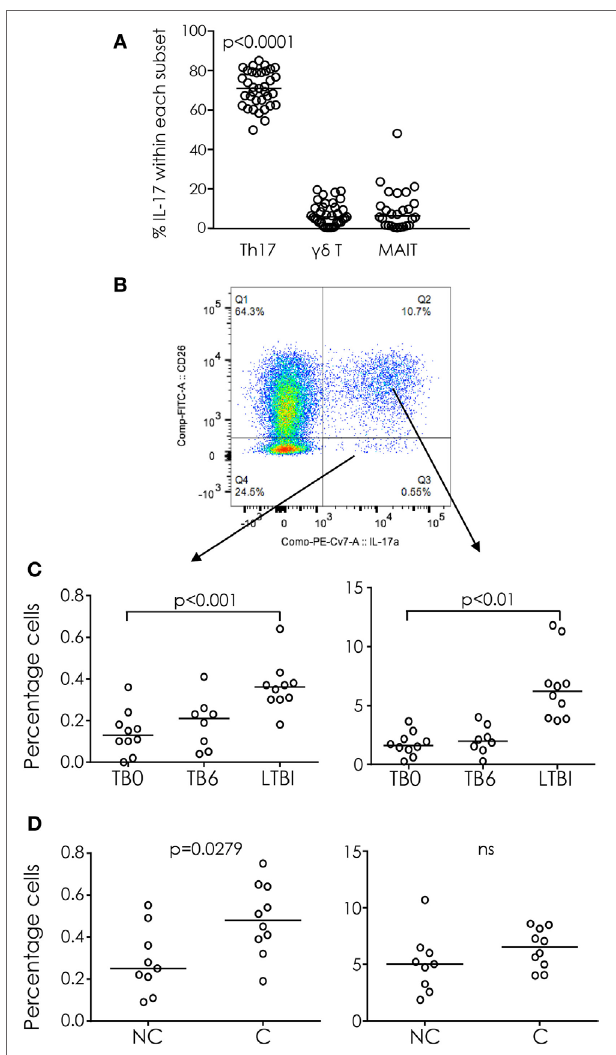
FigUre 1 | IL-17 producing cells in tuberculosis (TB) infection and disease. (a) Percentage of T helper 17 (Th17) cells, γδ T cells, and mucosal-associated invariant T (MAIT) cells within total IL-17 + cells (gated from lymphocytes). The majority of IL-17 was produced by Th17 cells. (B) Representative FACS plot of IL-17 production from CD26 + (Th17; upper right quadrant) and CD26 − (lower right quadrant) CD4 + cells. (c) IL-17 production from CD4 + CD26 − (left) and CD4 + CD26 + (right) cells from TB cases before treatment (TB0) and after treatment (TB6) and latently TB infected (TST + ). (D) IL-17 production from CD4 + CD26 − (left) and CD4 + CD26 + (right) cells from IGRA non-converters (NC) and converters (C). Data were analyzed using Kruskal–Wallis test with Dunn’s post-test comparison (a,c) or Mann–Whitney U -test (D) . Bar indicates